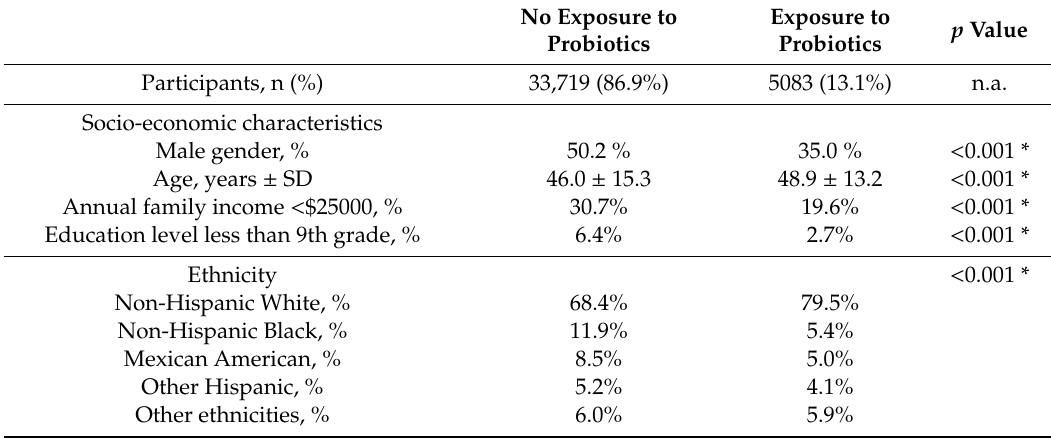
Table 1. Baseline population characteristics according to probiotic consumption ( n =